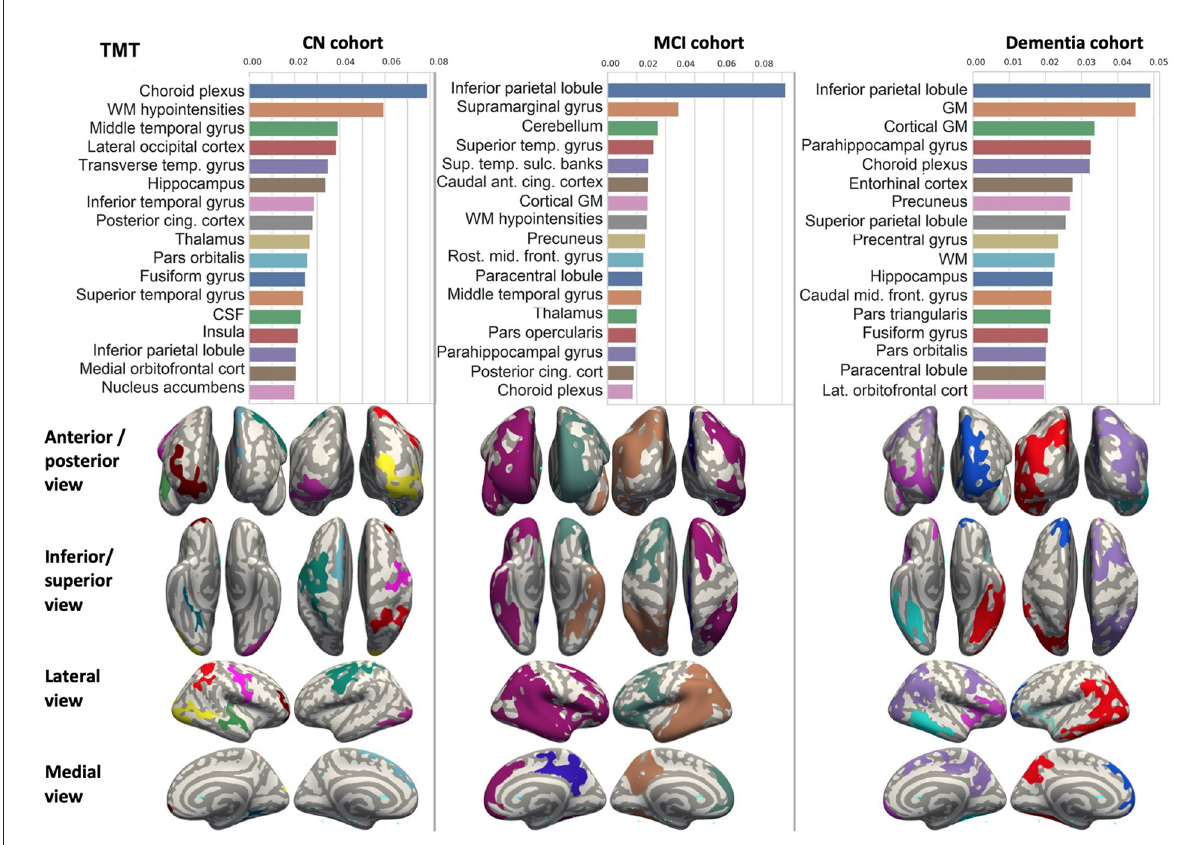
FIGURE7 Brain structures ranked according to information gain value for TMT score prediction. Inflated cortical representations showing significant correlations between cortical volumes and test